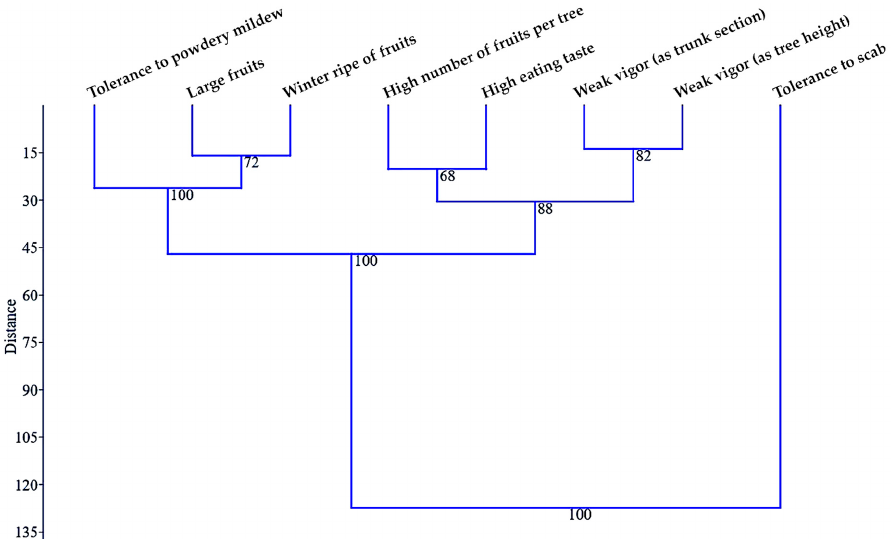
Figure 4. Hierarchical clustering algorithm with paired groups (UPGMA)—Euclidean similarity index of the analyzed traits in F 1 hybrids belonging to direct hybridizations and five testcrosses. If the arrangement of the vigor elements of the trees together in a common subcluster was to be expected, the positioning of a high number of fruits per tree and high eating taste in a common subcluster appeared quite surprising. The close relationship revealed by the multivariate analysis between these two traits may suggest that hybrids with a larger fruit load in the crown of the trees may produce fruits with a better taste. Similarly, another cluster with two close characters could indicate that the winter ripening of fruits can be associated with larger fruits. These two characteristics would be quite closely re ‐ lated to tolerance to powdery mildew attack. Extreme variation existed in the minimum of progeny required to produce a hybrid with quantitative traits of agronomic interest (Table 11). Regardless, this computed amount (if these traits behave independently) appeared extremely high depending on the type of hybridization (direct vs. testcross), the tester, and the cumulative traits of interest. Table 11. The minimum number of F 1 apple hybrids from hybridizations required to obtain an in ‐ dividual that inherited the optimal level for quantitative traits desired in selection. Type of Hybridizations Minimum Number of Offspring Required to Obtain an Individual Hybrid with the following Associated Quantitative Traits *: a + b a + b + c + d a + b+ c + d + e a + b + c + d +e + f a + b + c + d + e + f + g1 a + b + c + d + e + f + g2 Direct—type A × B (21 combinations)